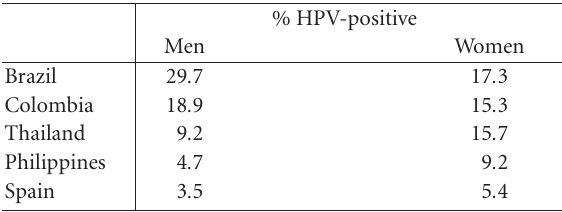
Table 8: Cervical and penile HPV prevalence in control